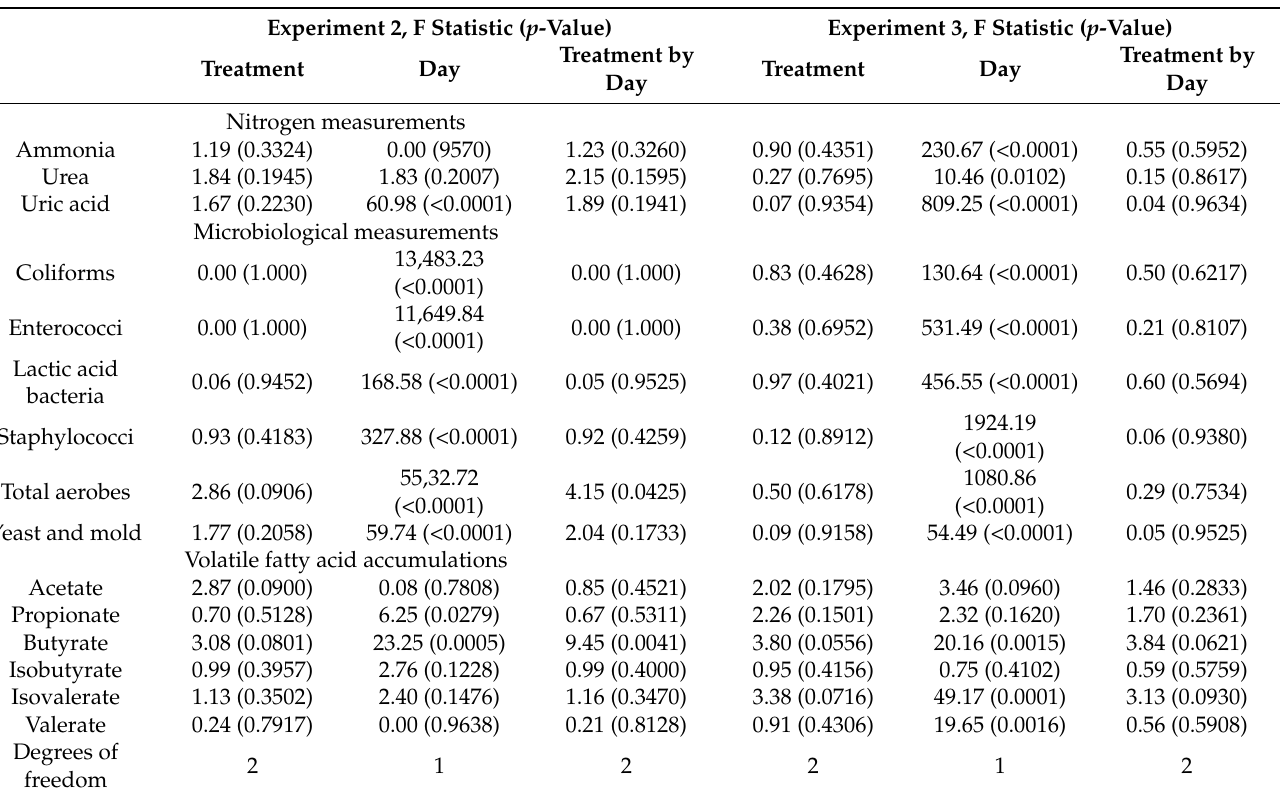
Table 2. Analysis of variance results for effects of hops treatments, day of compost, and their interactions on nitrogen and select microbiological populations after 14 days of simulated composting of a 3:1 mixture of wood chip poultry litter mixed without (Experiment 2) or with ground bluestem hay (Experiment 3) 1 .